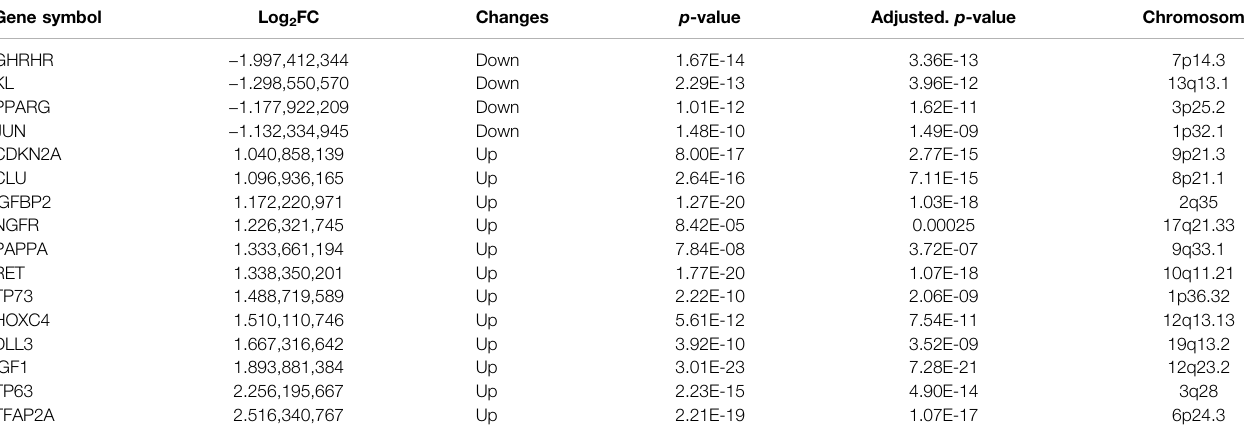
TABLE 1 | The 16 differentially expressed aging-related genes in IPF samples compared to healthy samples. Gene symbol Log 2 FC Changes